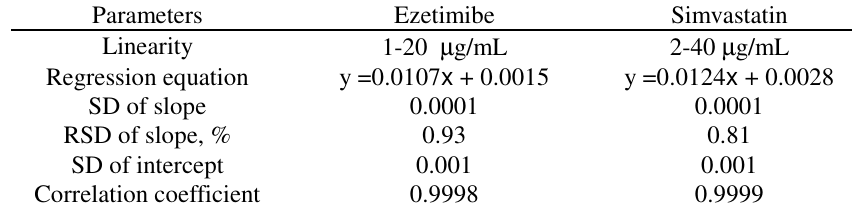
Table 1. Statistical data of calibration curves of ezetimibe and simvastatin in mixtures with different concentrations using first-order